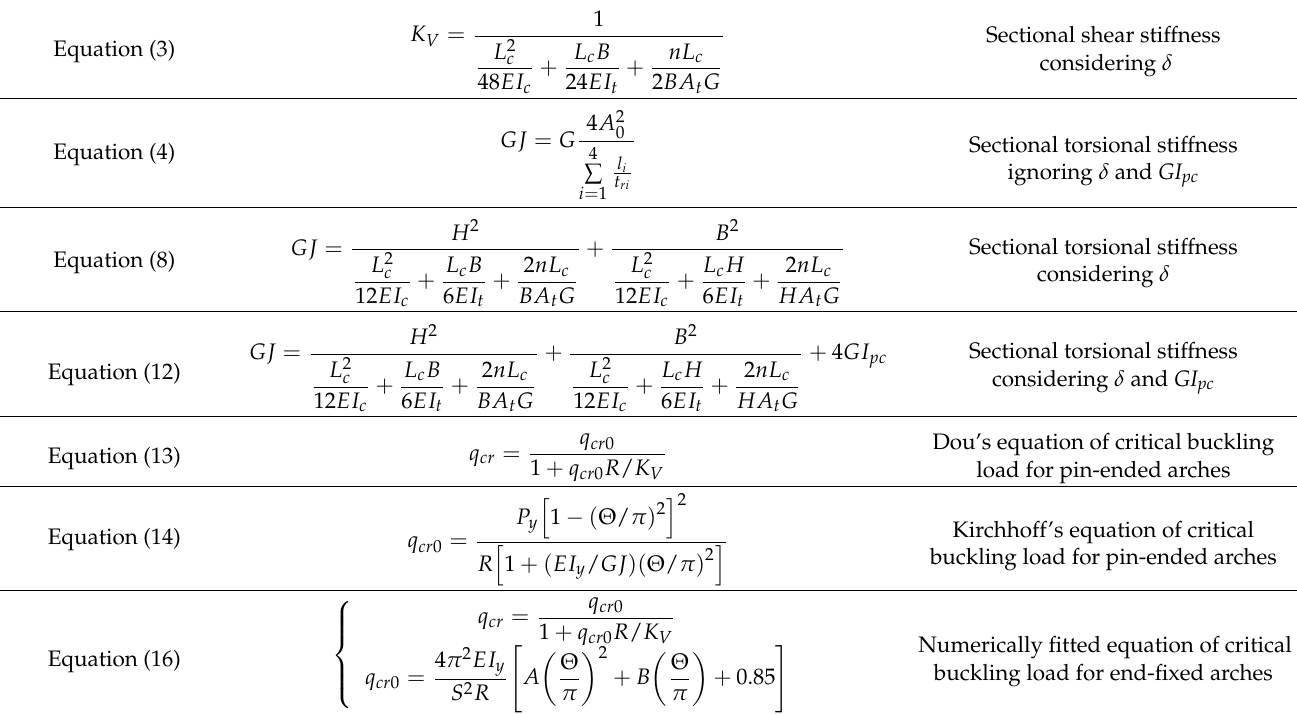
Table A1. Equations and their